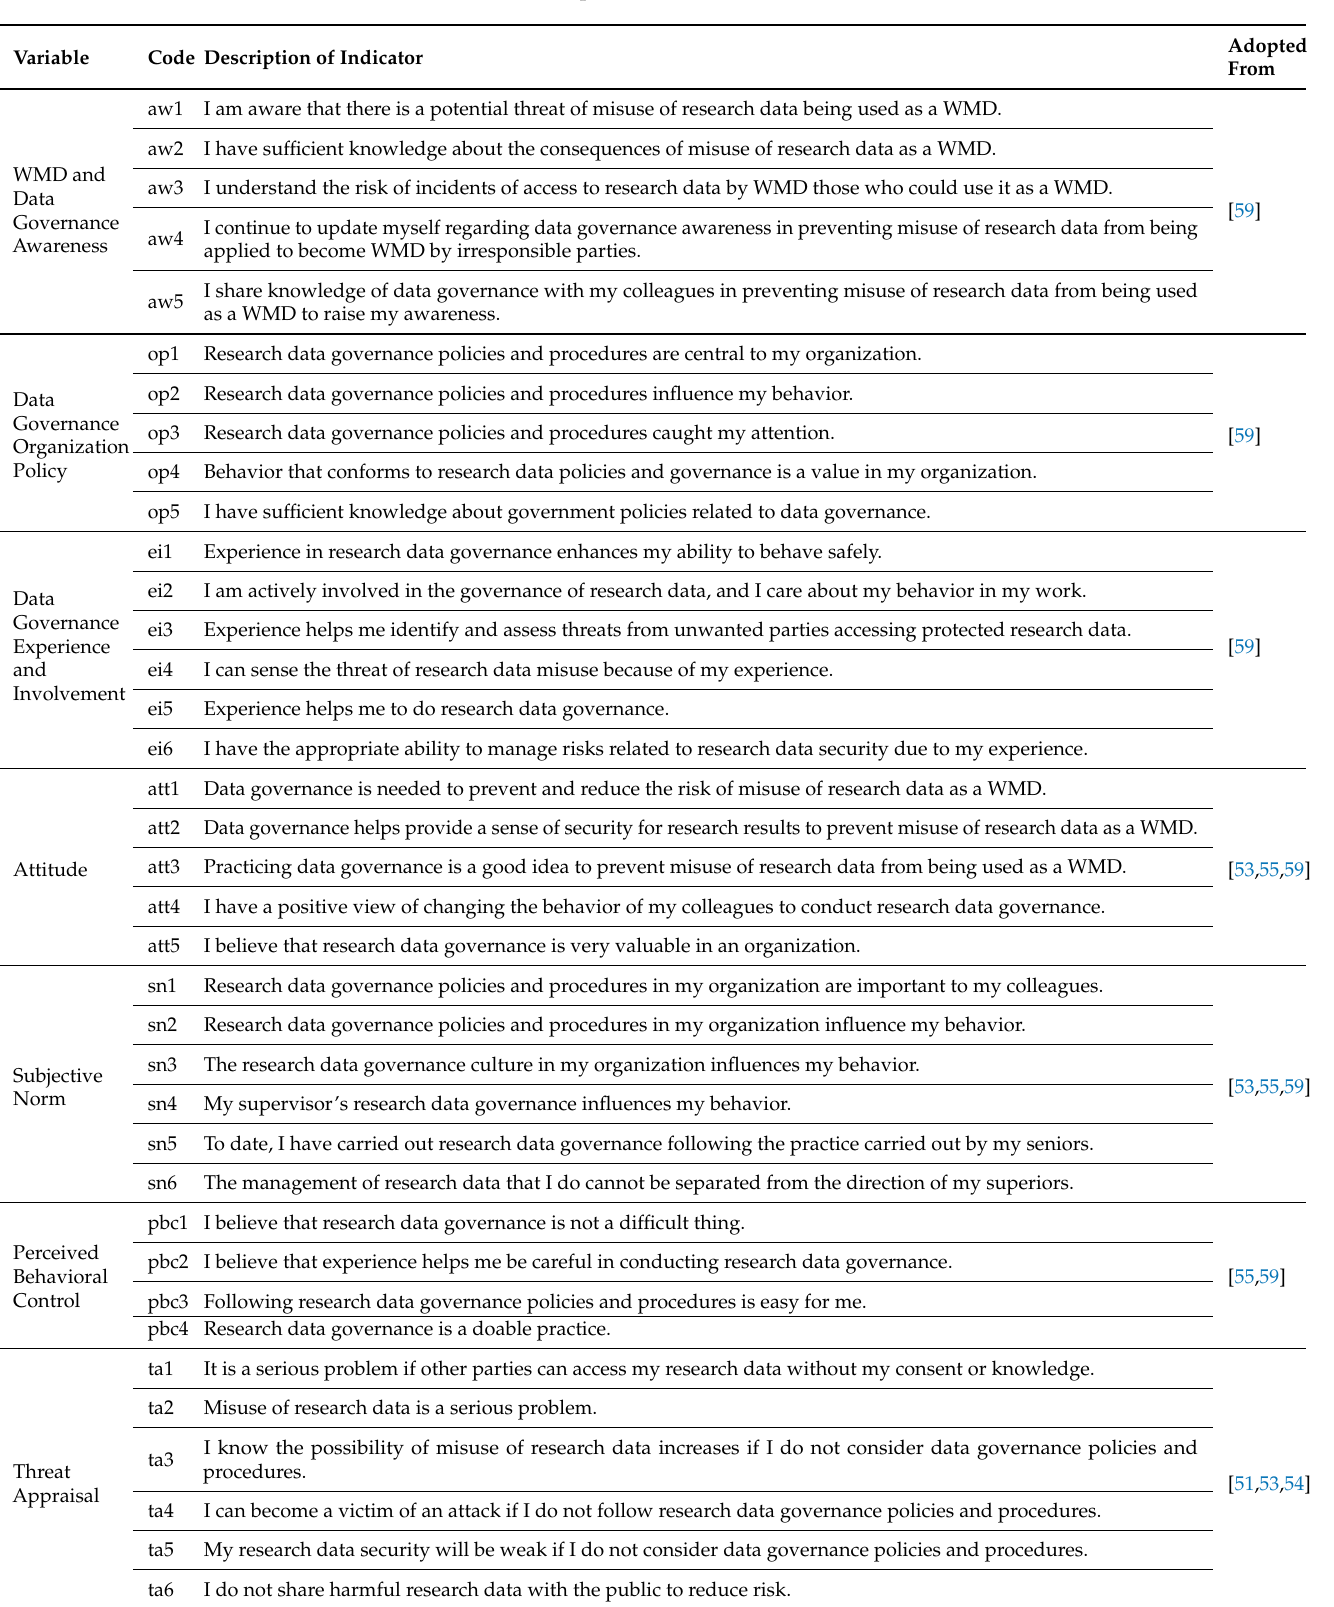
Table A3. Questionnaire: part